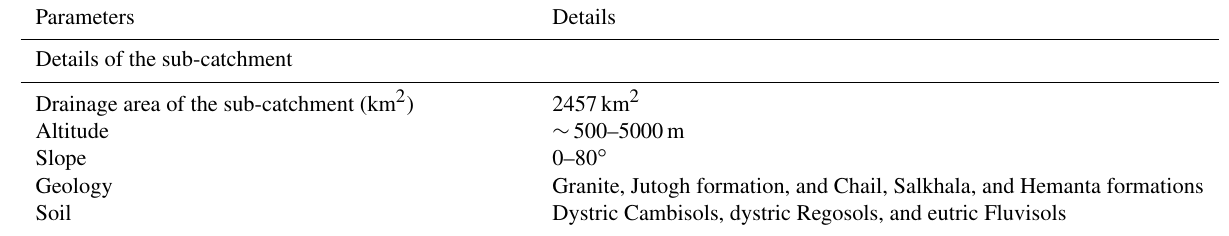
Table 1. Characteristics of the study catchment over the evaluation period of